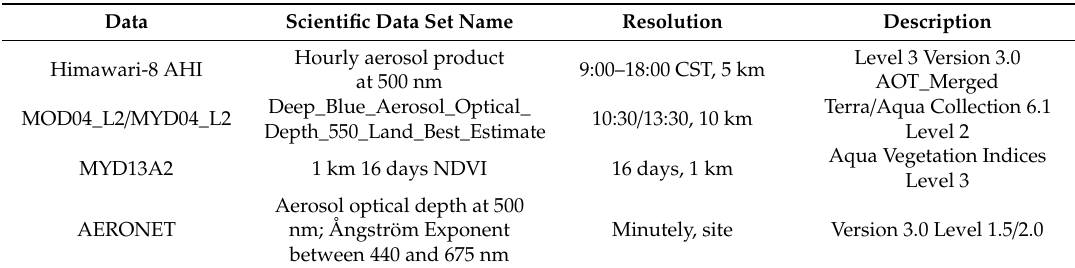
Table 1. Summary of datasets used for evaluation